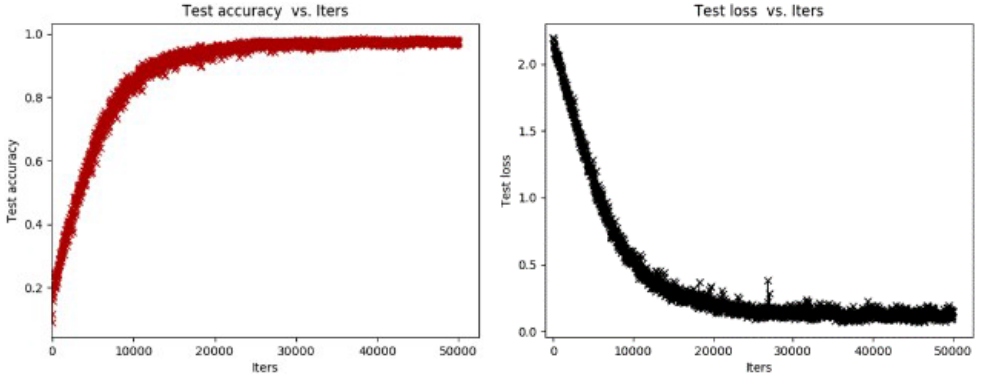
Fig. 13 The training and test results of the improved